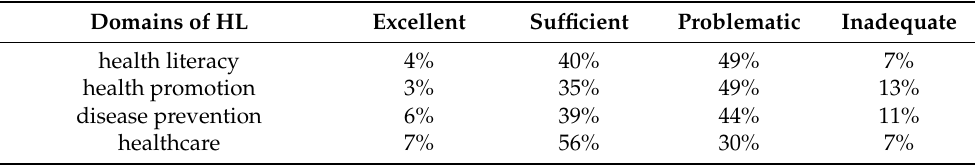
Table A2. Health literacy (HL) levels among the study population by